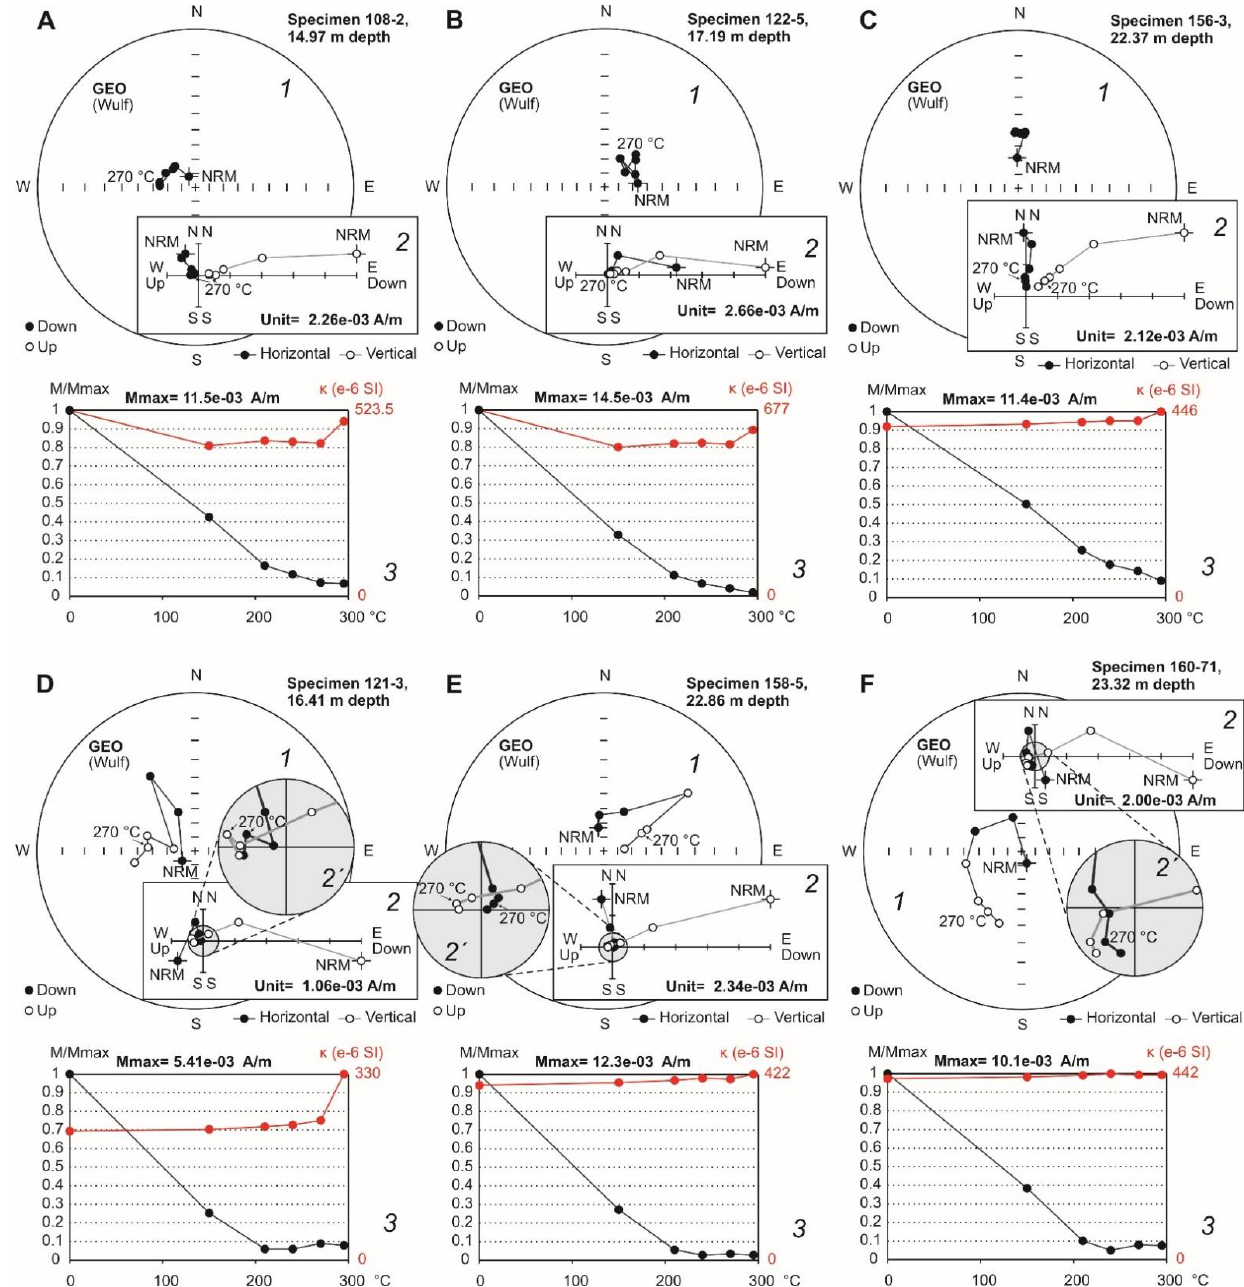
Figure 7. Examples of stepwise thermal demagnetisation of palaeosol specimens from ( A ) the D-S5S1 (lb b2 ) subunit, ( B ) D-S6S1 (mr 3 ) subunit, ( C ) upper part of the D-S7S3 (sh 1b1 ) subunit, ( D ) loess specimen from the D-L6 (sl) unit, palaeosol specimens from ( E ) the lower part of the D-S7S3 (sh 1b1 ) subunit and ( F ) lower part of the D-S8S1 (kr 3 ) subunit. 1 — stereographic projections of demagnetisation directions (full and open circles represent projections in the lower and upper hemispheres, respectively); 2 — orthogonal demagnetisation paths (Zijderveld diagrams) on horizontal and vertical planes; 3 — NRM intensity decay curves of demagnetisation (M/M max ) and magnetic susceptibility (κ) variations after each demagnetisation step. Additional Zijderveld plots enlarged 5 times are shown in circular insets ( 2 ’ ).